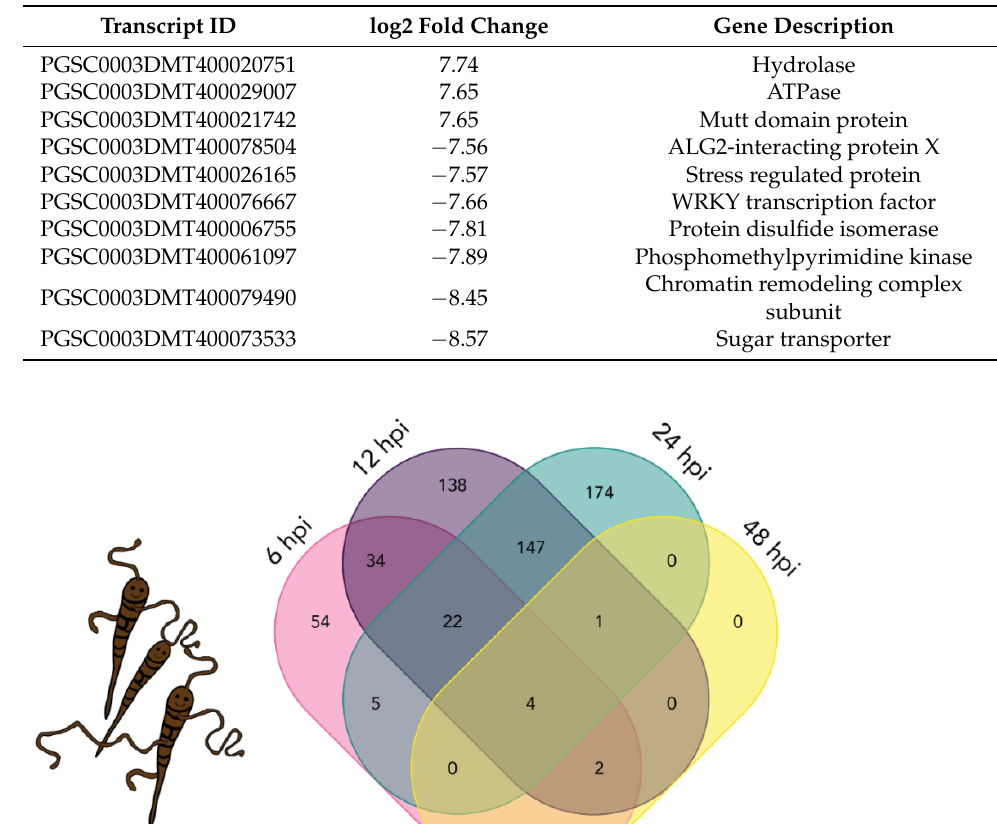
Table 2. Top 10 differentially expressed potato transcripts in A. solani inoculated samples at 1 hpi. Transcript ID, log2 Fold change, and the gene descriptions are displayed.